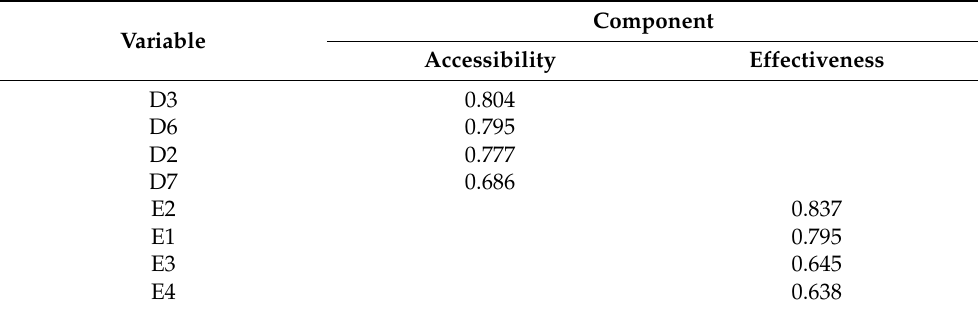
Table 5. Pattern matrix for the EFA